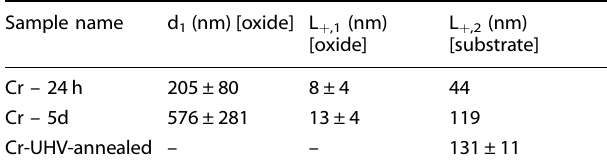
Table 1. Calculated using VEPFit code thickness, and effective diffusion lengths, L + , for the oxidized and a reference sample.